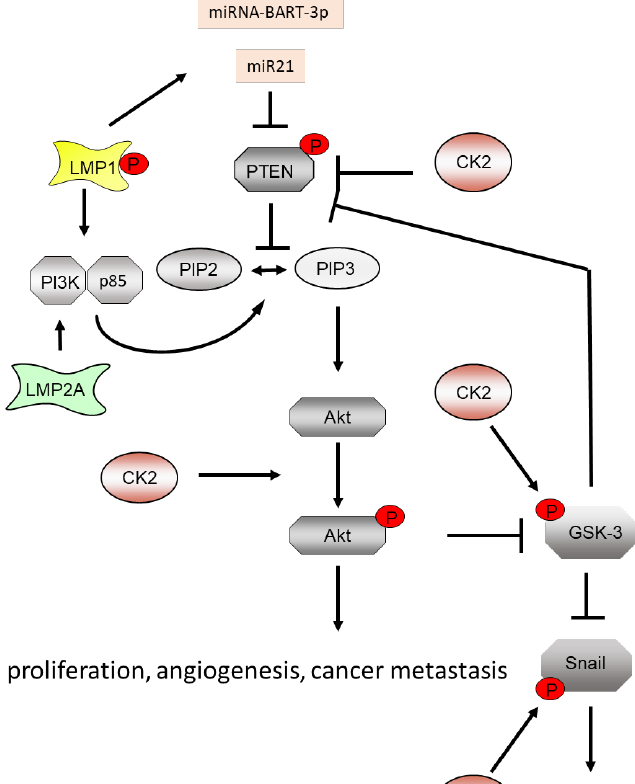
Figure 2. LMP1, miRNA-BART-3p and CK2 regulate the PI3K/Akt signaling pathway. CK2 phosphorylates PTEN, Akt and Snail to regulate the PI3K/Akt signaling pathway in order to induce proliferation, angiogenesis, cancer metastasis and epithelial and mesenchymal transition (EMT).